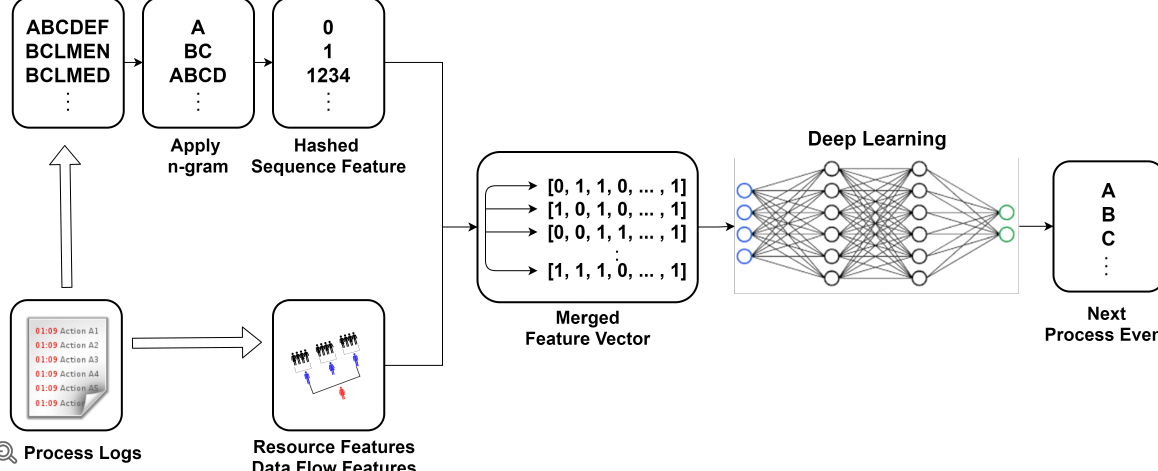
Figure 2. Process prediction using n-gram and feature hashing